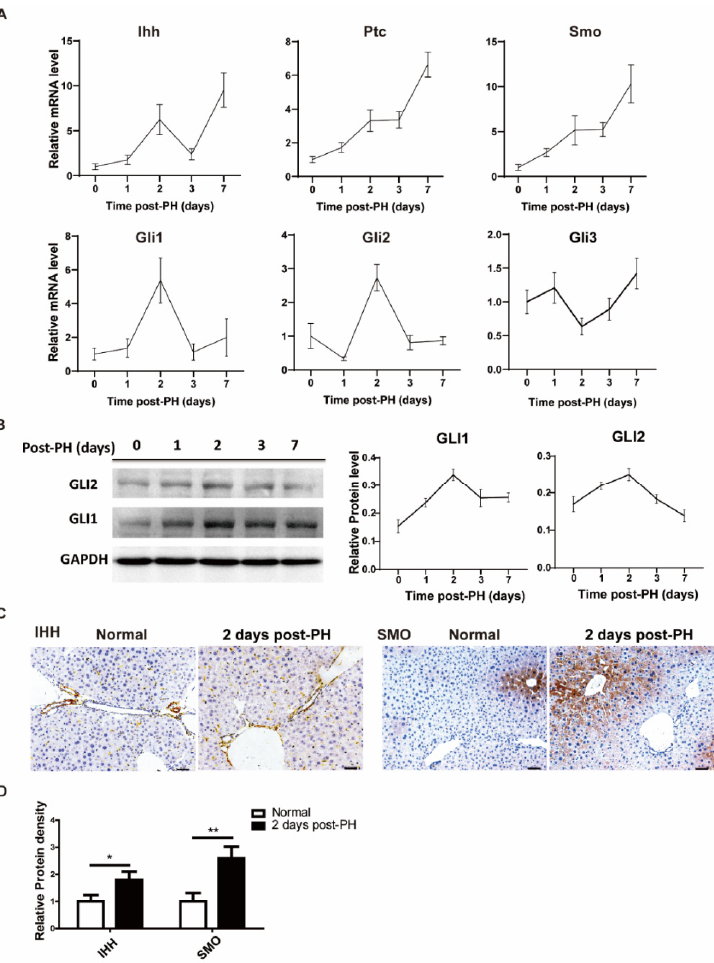
Figure 1. Hedgehog signal activated after PH. ( A ) mRNA change trend of Hh signaling pathway ( IHH , PTC , SMO , GLI1 , GLI2 , GLI3 ) in liver tissue of mice at different time points after PH (0, 1, 2, 3 and 7 days), n = 5. ( B ) Representative Western blot results of GLI1 and GLI2 in the liver tissues of mice at different time points after PH (0, 1, 2, 3 and 7 days). Western blot quantification analysis compared to GAPDH is shown in the line chart, n = 3. ( C ) Representative immunohistochemical results of IHH and SMO staining in liver of normal mice and two days after PH, bar means 50 µ m. ( D ) Results of IHH and SMO immunohistochemical quantitative analysis, analyzed with Image J, 5 pictures for each group, n = 3. All data represent means ± SEM. * p < 0.05, ** p < 0.01 vs. control